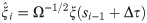
The main step in the pcLNA algorithm.The solid horizontal bars below the horizontal axis are all of length Δτ, the basic time step of the algorithm. The black arrows show ξ^i=Ω-1/2ξ(si-1+Δτ) and the grey arrows κ^i=Ω-1/2κ(si). Having calculated κ^(si-1) one uses κ(si − 1) as the initial state and updates it using the LNA and a time-step Δτ to obtain ξ at si − 1 + Δτ. Then ξ(si − 1 + Δτ) is replaced by κ(si) so that g(si − 1 + Δτ) + Ω−1/2
ξ(si − 1 + Δτ) = g(si) + Ω−1/2
κ(si) where κ(si) is normal to the limit cycle. Therefore, si gives the phase of κ(si) and the corresponding time is ti = t0 + iΔτ.